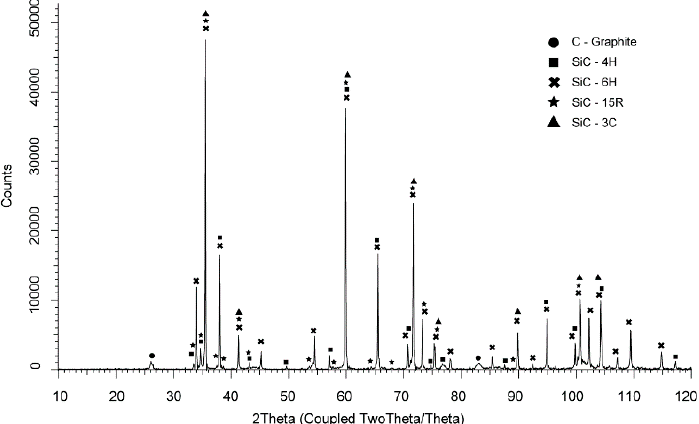
Figure 9. XRD pattern of the 0/100 SiC sinter with graphene addition.